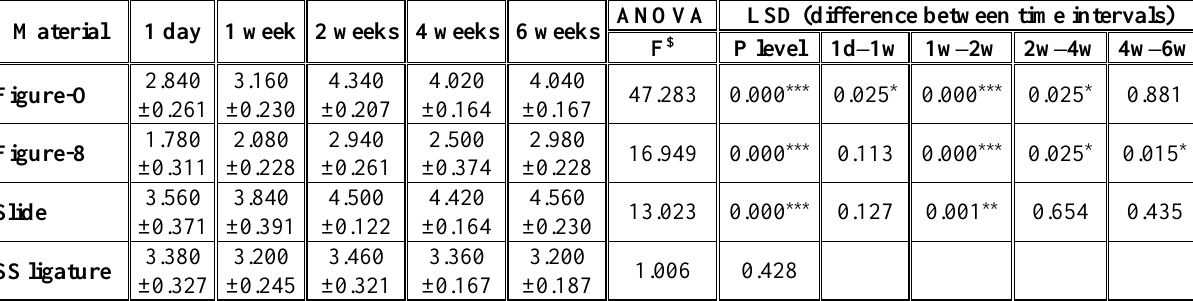
Table 1: Descriptive statistics (Mean ±S.D.) of the distance moved (in mm) with ANOVA and LSD tests for the difference between the time intervals. Material